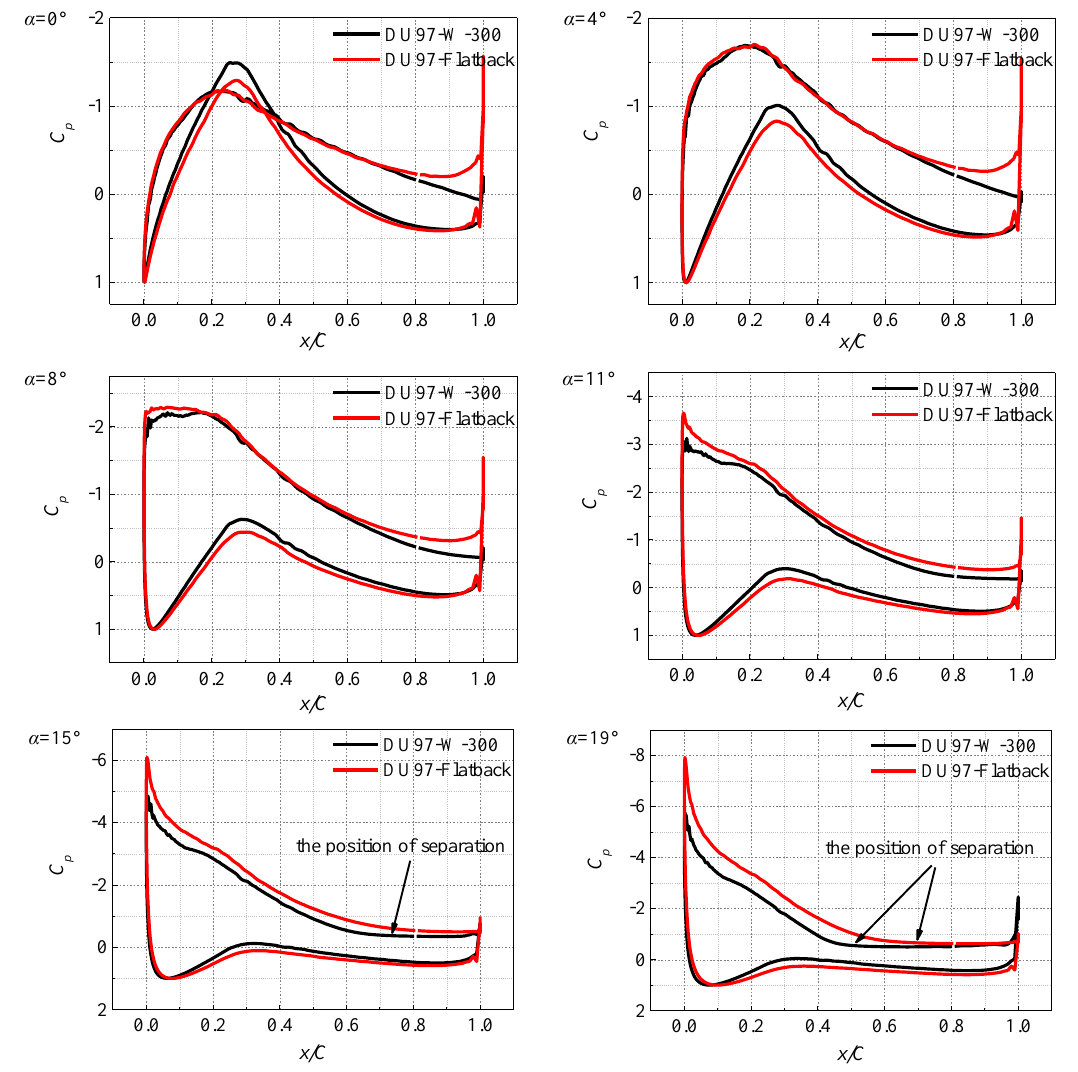
Figure 11. Distribution of pressure coefficient on airfoil surfaces.